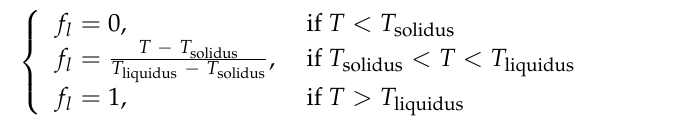
Figure 3. Scanning diagram of Ultrasonic Detection.